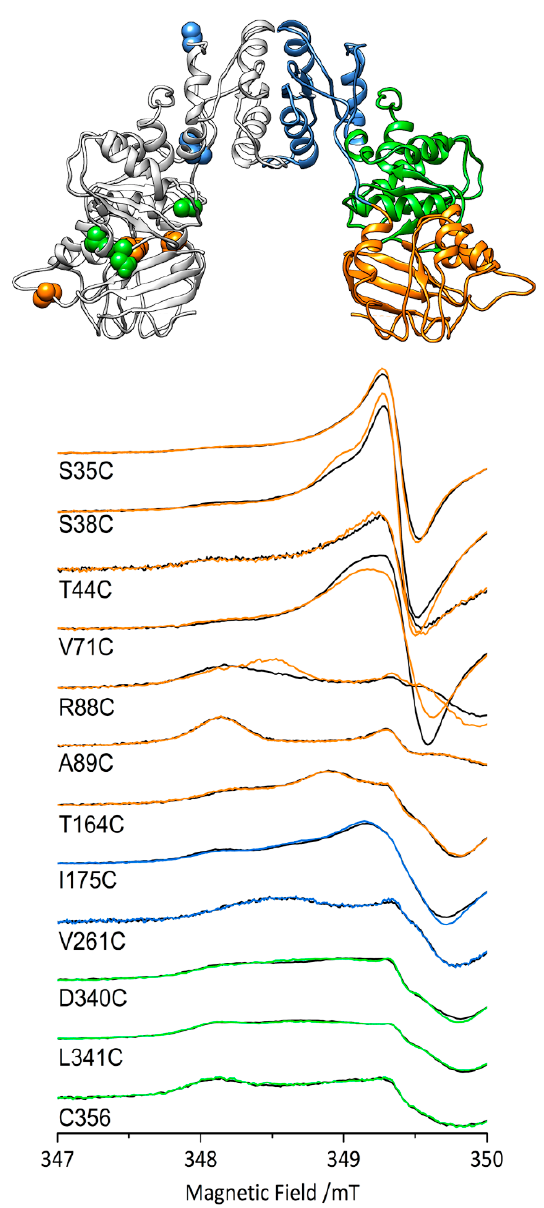
Figure 5. Top. The structure of HydF from T. neapolitana (pdb.id 3QQ5) with the mutated labeling sites highlighted in the same color of the domain they are located in (orange, GTPase; blue, dimerization; green, cluster binding). Bottom. EPR spectra (zoom of the low field region) of HydF from T. neapolitana spin labelled at the indicated positions: black, the spectra in the absence of GTP; colored lines, the spectra in the presence of GTP. The figure is based on the results reported in reference [57].